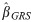
The effect of BMIGRS on BMI.The regression model (stratified by exercise types) was built as BMI = β0 + βGRS
BMIGRS + βCCovariates + ε, where BMIGRS was calculated at the marginal-association P-value threshold of 0.05. We used this BMIGRS for plots because 0.05 is generally considered as the significance level in statistical analyses. The orange bars represent β^GRS on BMI (stratified by exercise types), and the black segments mark [β^GRS−standarderrorofβ^GRS,β^GRS+standarderrorofβ^GRS]. The text on each bar is the P-value of testing H0: βGRS = 0 vs. H1: βGRS ≠ 0. Covariates adjusted in the regression model included sex, age, educational attainment, drinking status, smoking status, and the first 10 PCs. Consistent with Table 3, the 18 kinds of exercise were sorted according to popularity.